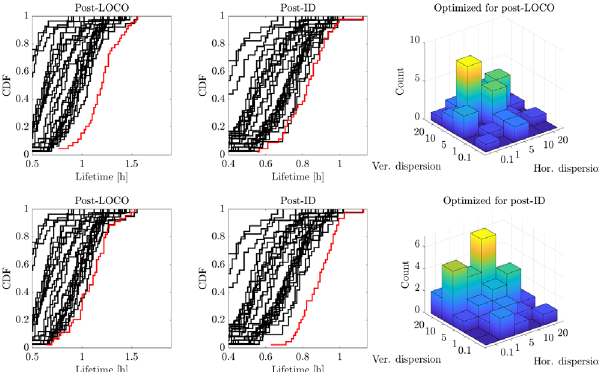
FIG. 16. Lifetime optimization using LOCO dispersion weights. The histogram in the right plots shows the value of horizontal and vertical dispersion weight yielding the best life- time without IDs (upper row) and after ID compensation (lower row). The black lines in the left and center plots show the lifetime for each pair of dispersion weights, the red lines indicate the lifetime when for each error realization the best value is chosen. The optimum dispersion weights with and without IDs